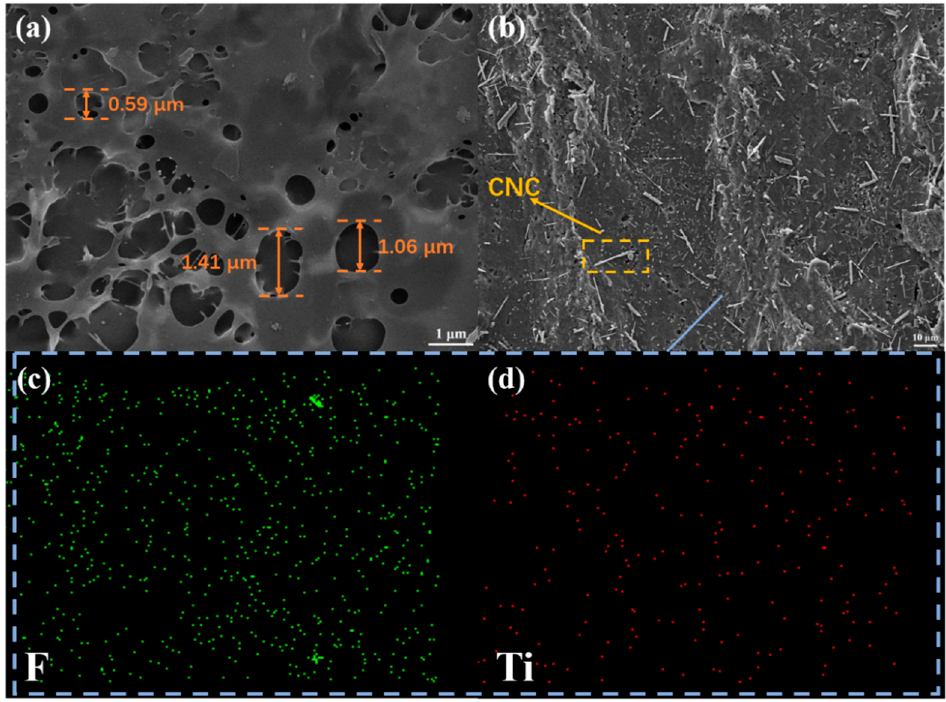
Figure 3. ( a , b ) Scanning electron microscopy (SEM) images of C–CMP composite foam. ( c , d ) Elemental mapping images of C–CMP showing the presence of F and Ti.